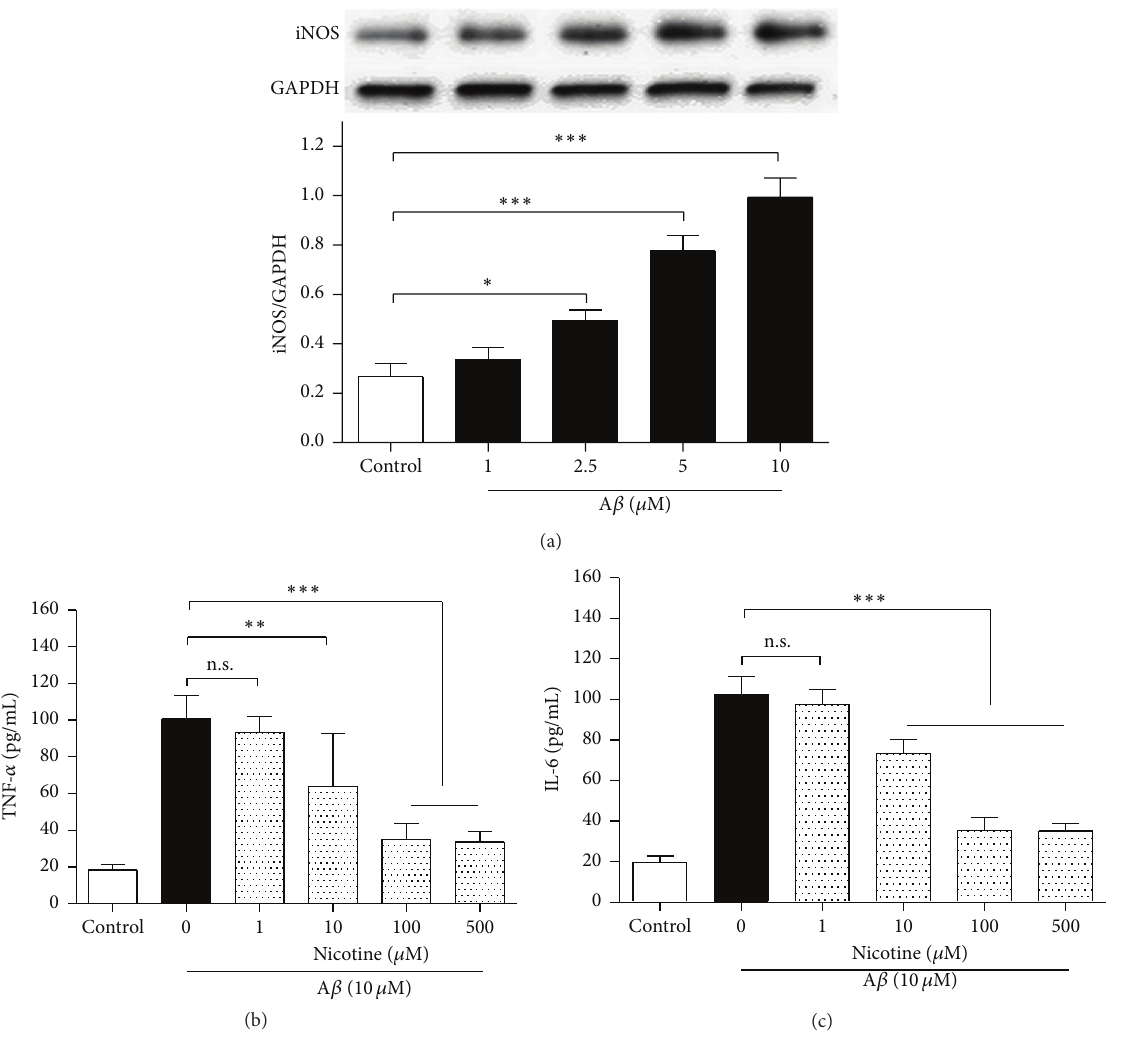
Figure 1: Nicotine decreased TNF- 𝛼 and IL-6 releases from A 𝛽 -stimulated microglial cells in a dose-dependent manner. (a) A 𝛽 exposure increased iNOS expression. The N9 microglial cells were exposed to different concentrations of A 𝛽 for 24h ( 𝑛 = 4 ). (b) Nicotine decreased TNF- 𝛼 release ( 𝑛 = 6 ). (c) Nicotine decreased IL-6 release ( 𝑛 = 6 ). Results are expressed as means ± SD, ∗ 𝑃 < 0.05 , ∗∗ 𝑃 < 0.01 , ∗∗∗ 𝑃 < 0.001 ; n.s.: no